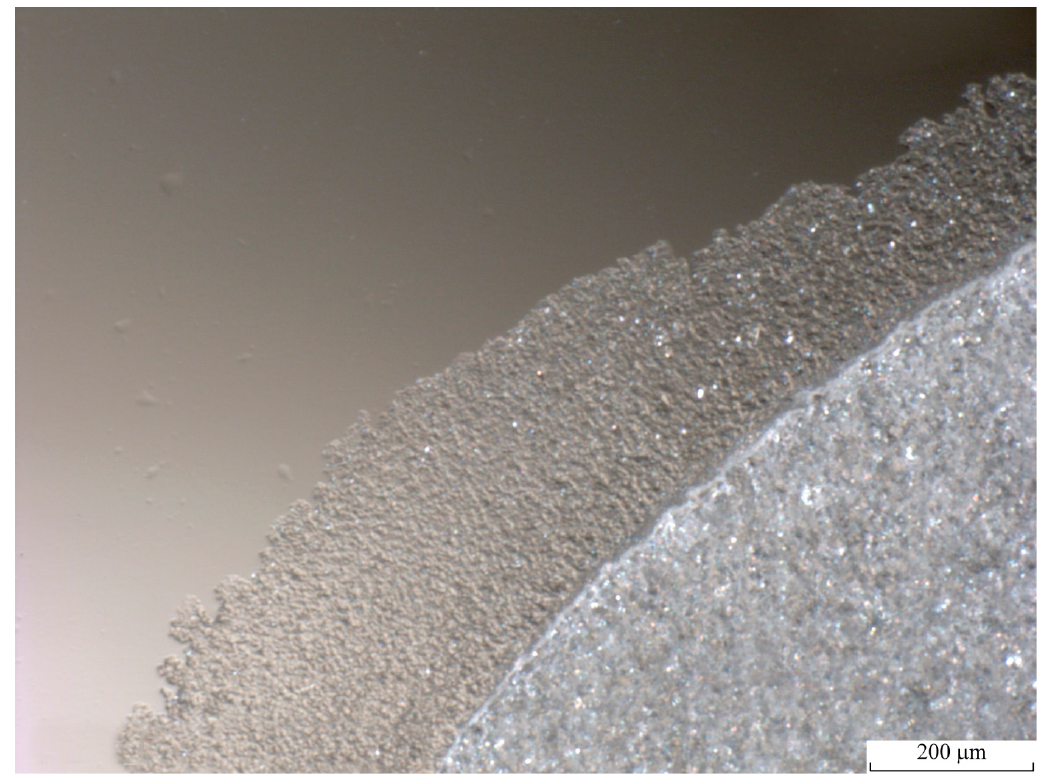
Figure 6. A dense fine-grained form of xenon hydrate. Observed at +9 °C, 8 atm.